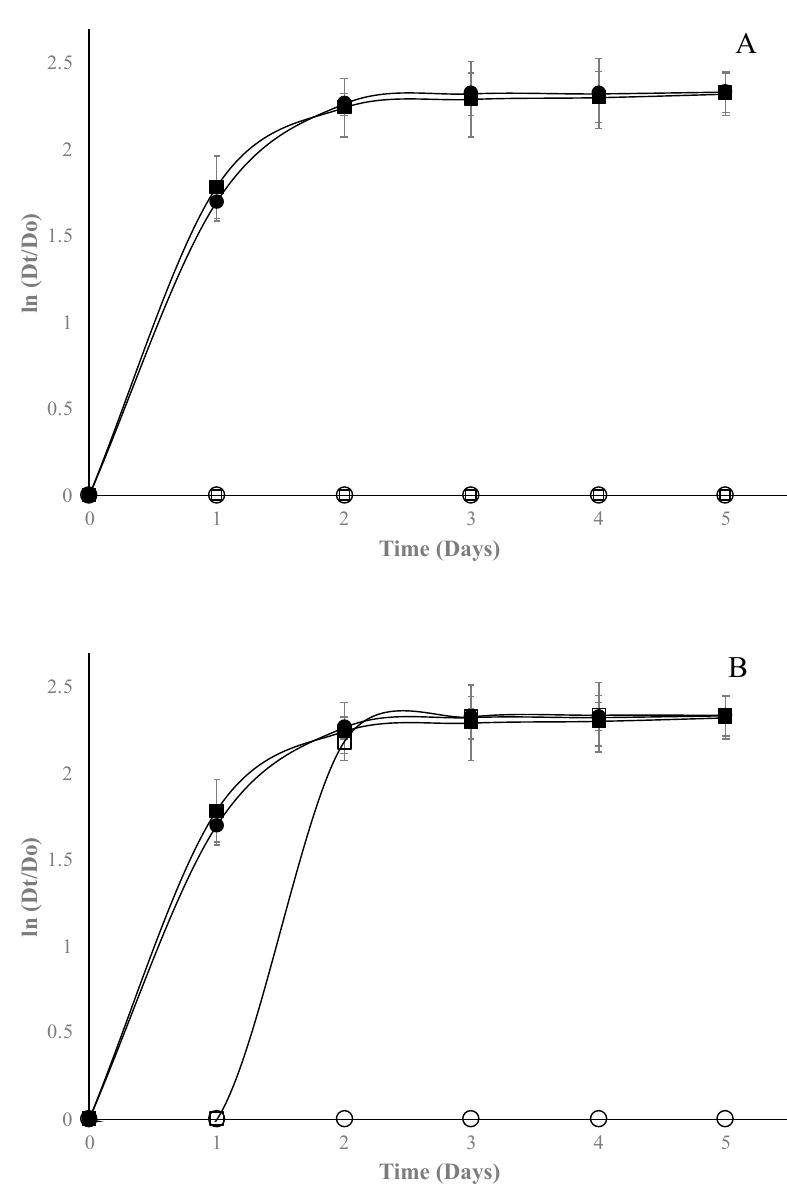
Figure 6. Effect of starch edible films added with selected concentrations of Mexican oregano ( Lippia berlandieri Schauer) essential oil (control [ ], 0% [ ], 1% [ ], and 2% [ ]) on Rhizopus spp. growth with different nanocomposites, bentonite ( A ) or halloysite ( B )